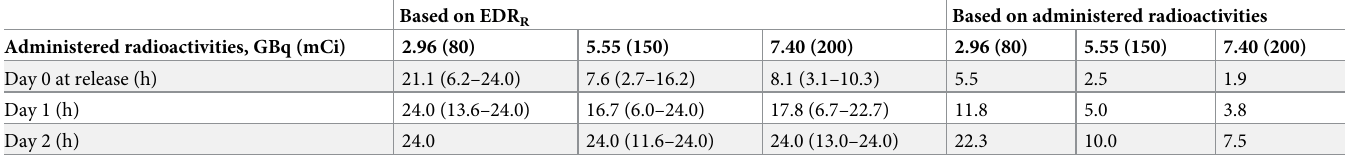
Table 2. Maximum permissible time to use public transportation based on EDR R compared to those based on administered radioactivity. Based on EDR R Based on administered radioactivities Administered radioactivities, GBq